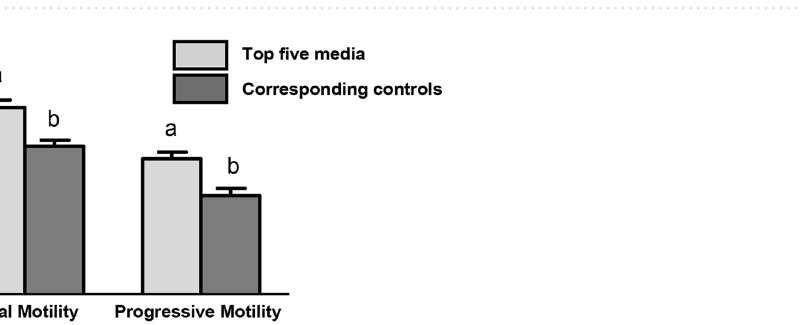
Figure 4. Direct comparison of media generated by differential evolution to commercial medium for media at generation 17 using the total motility metric and at generation 21 using the relative total motility metric.